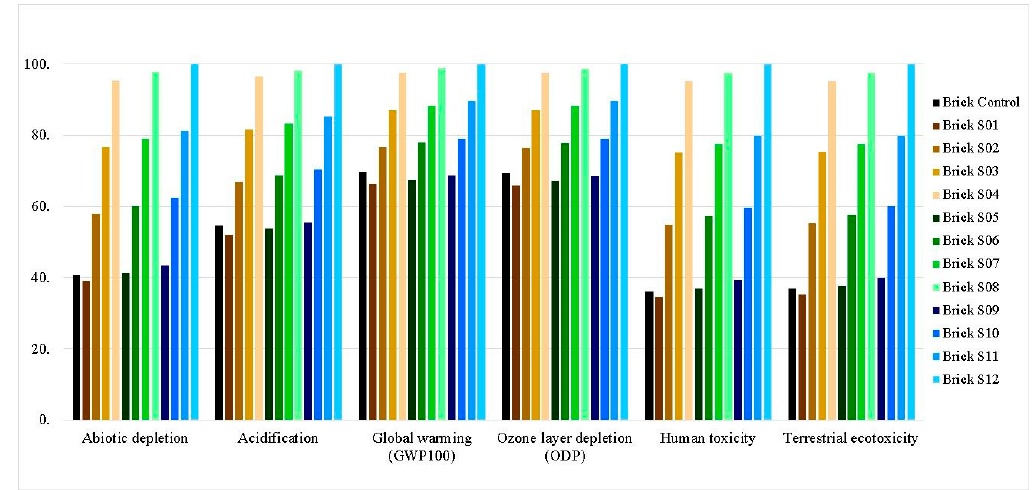
Figure 10. The comparative environmental impacts of concrete brick production of each ratio.